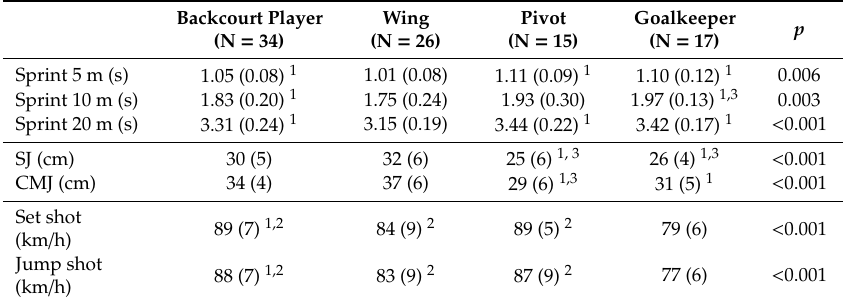
Table 3. Di ff erences between playing positions in sprinting, vertical jump performance, and handball shooting performance.